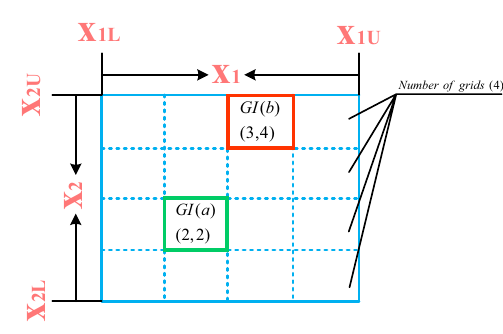
Fig. 1 Grid division in a space with two random